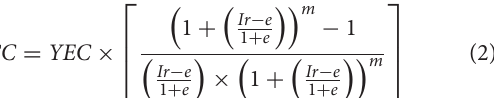
(n) Labor cost before and after